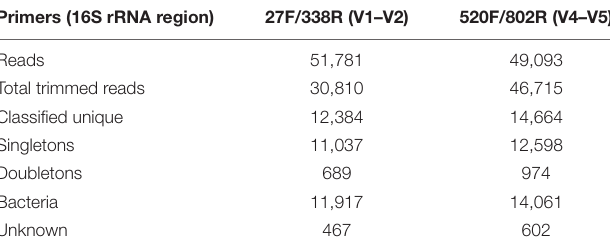
TABLE 2 | 16S rRNA gene amplicon pyrosequencing